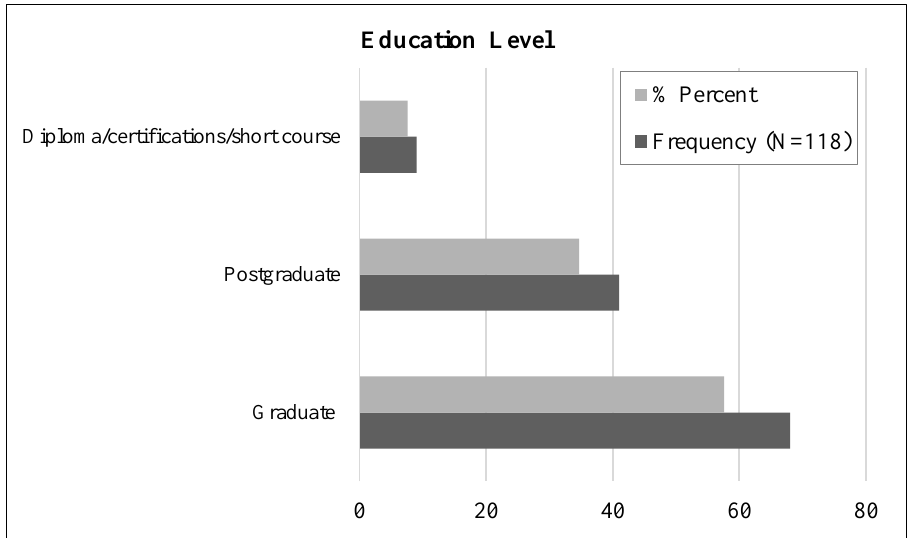
Figure 8. Educational level of the